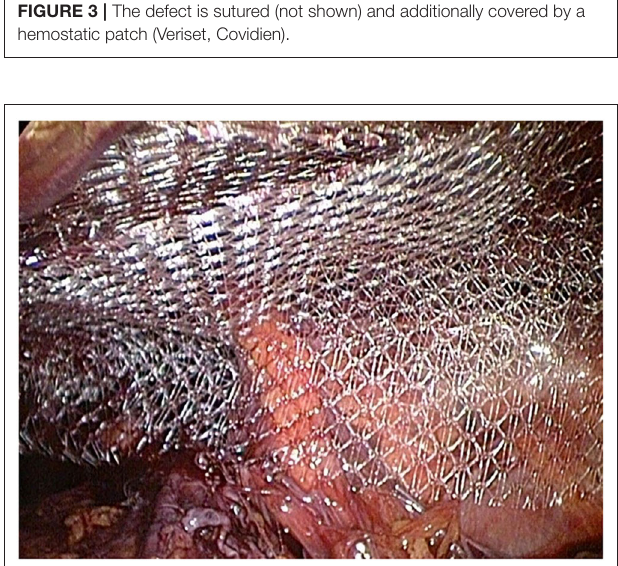
FIGURE 4 | The inguinal hernia is supplied with polypropylene mesh in double mesh technique (Bard, SoftMesh).